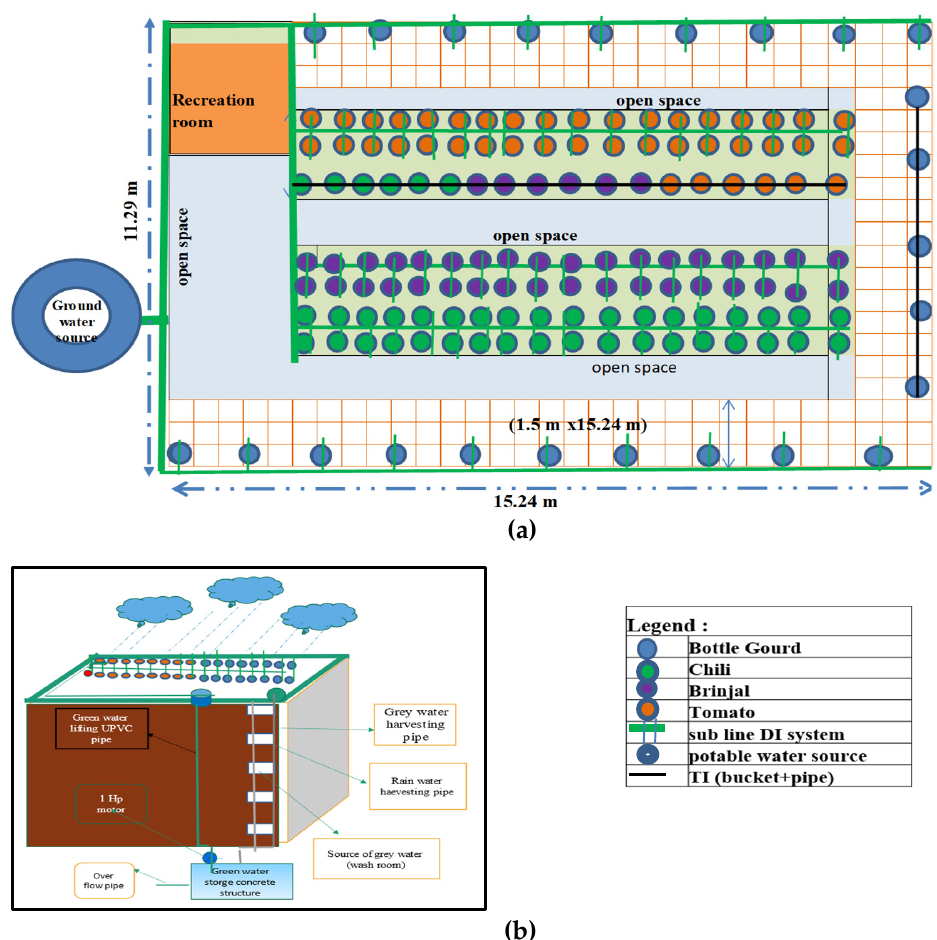
Figure 2. Drip irrigation setup n the experimental plots: ( a ) ground water source; ( b ) rainwater and grey water source.